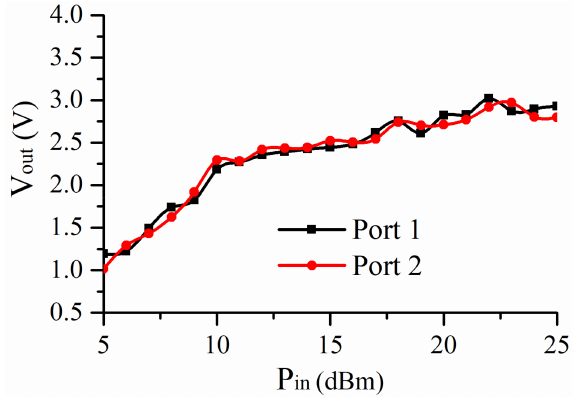
Figure 12. Output voltage vs. input power.